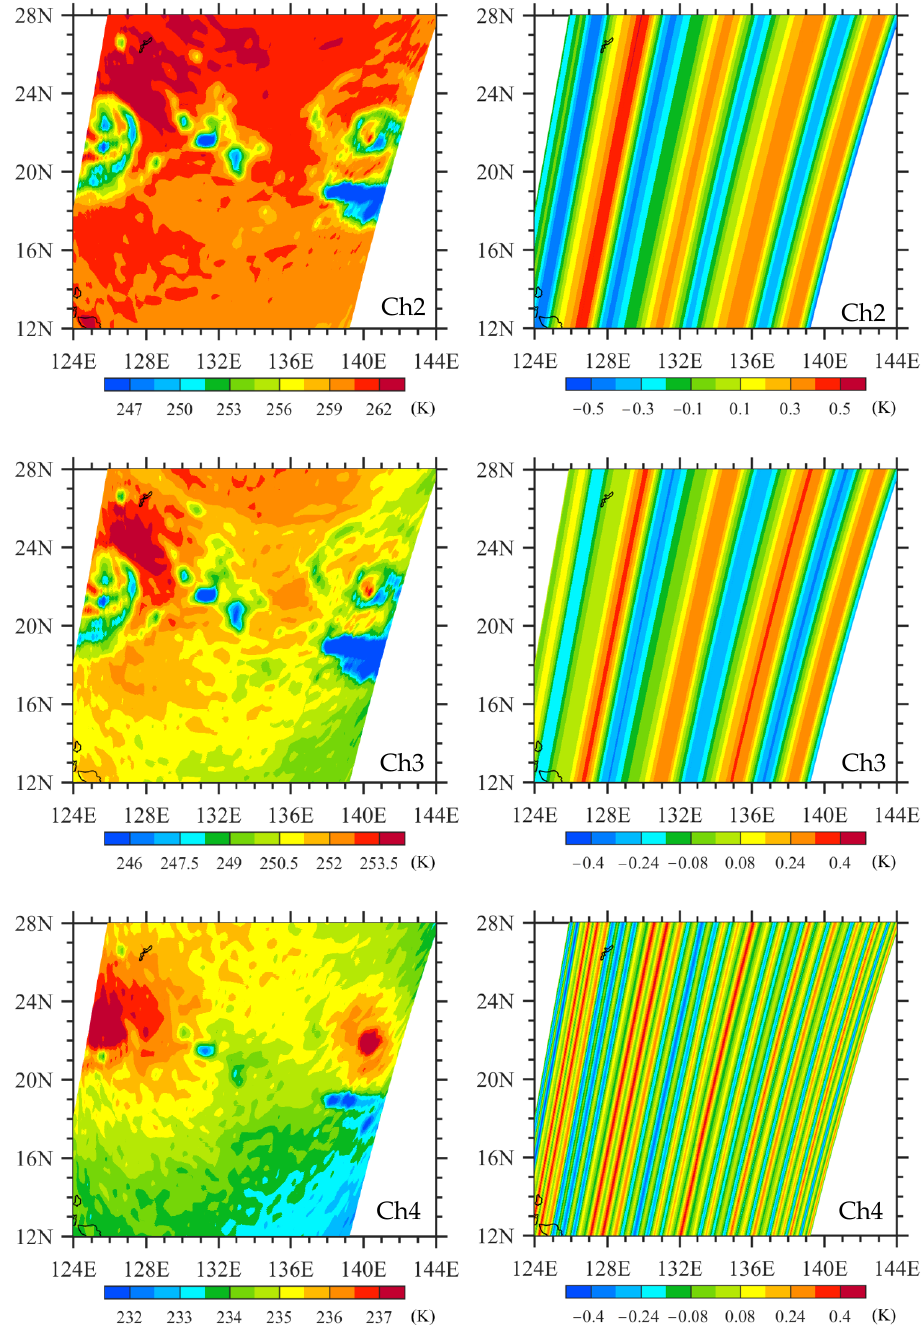
Figure 10. TB observations at channels 2–4 ( left panels ) and the across-track noise ( right panels ) over same portion of the swath in Figure 3a as those in Figure 5.